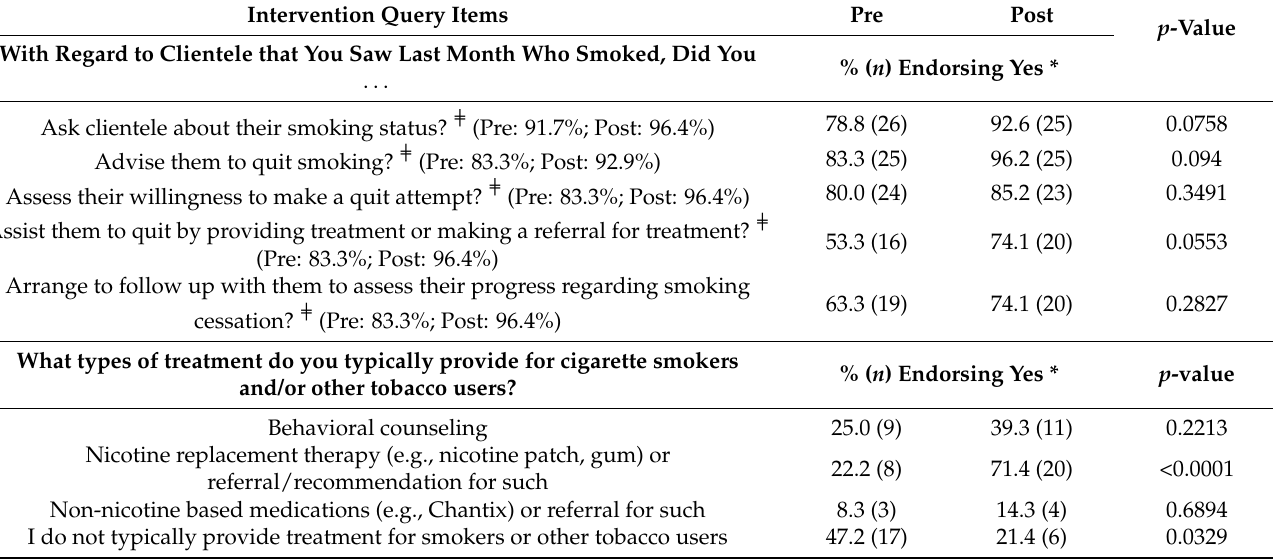
Table 2. Training receipt from pre- to post-implementation among responding employees and cli- nicians in opioid addiction treatment centers. ‡ Table 3. Intervention provision from pre- to post-implementation among responding clinicians (6 opioid addiction treatment centers).